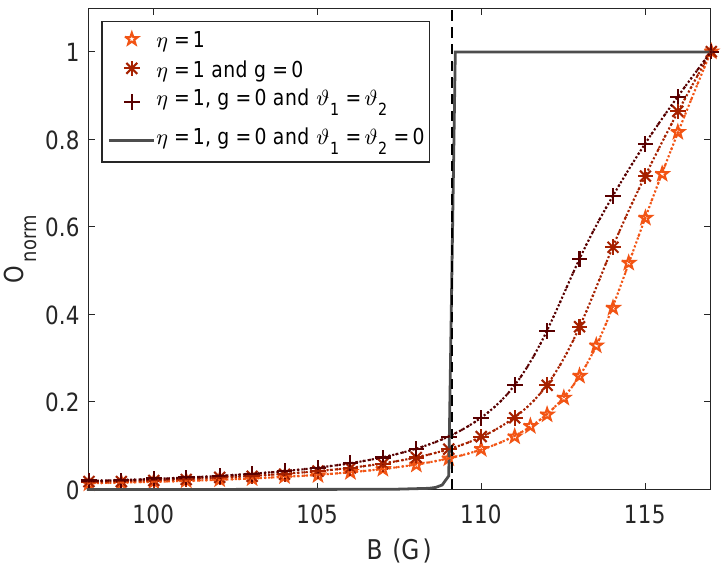
Figure 6. Normalized overlap, O norm , as a function of the Feshbach field, B , for η = 1 under different trapping conditions (see main